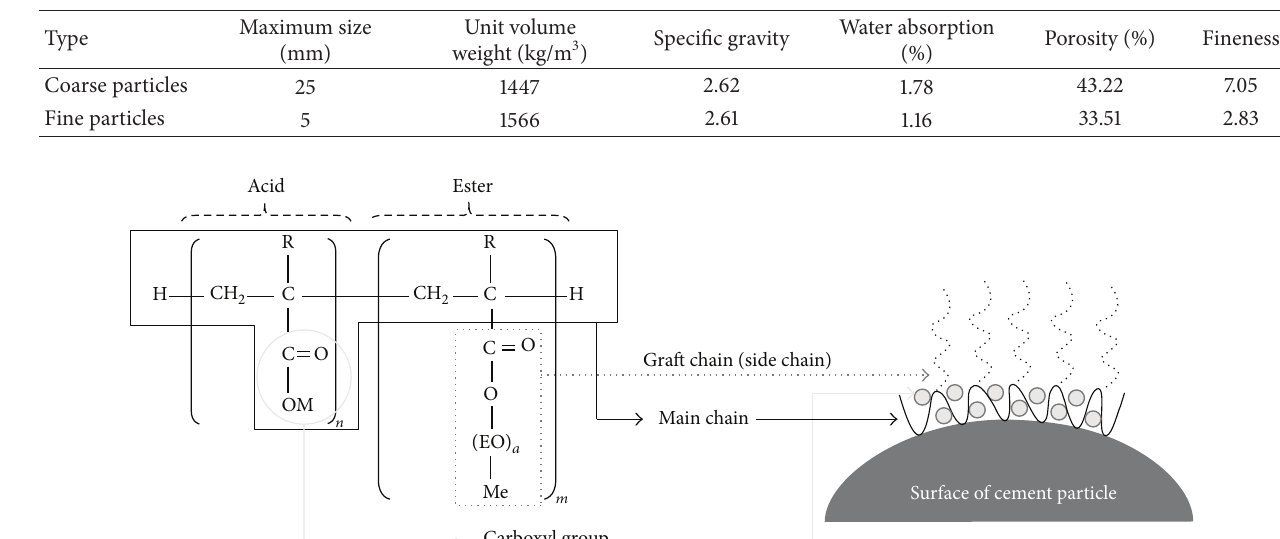
Table 2: Physical properties of aggregates used.